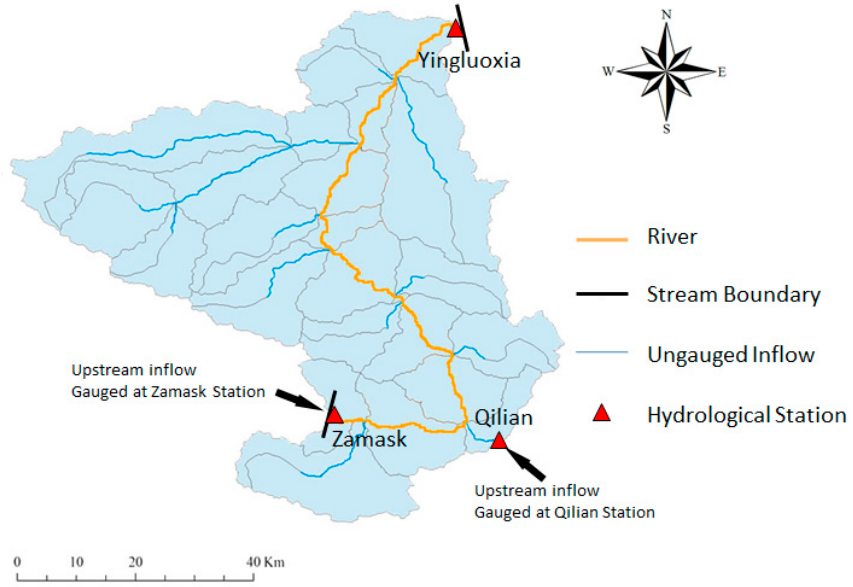
Figure 2. Segments, hydrological response units, and data station locations in the Zamask-Yingluoxia subbasin. Data of precipitation and flow are available in three hydrological stations.